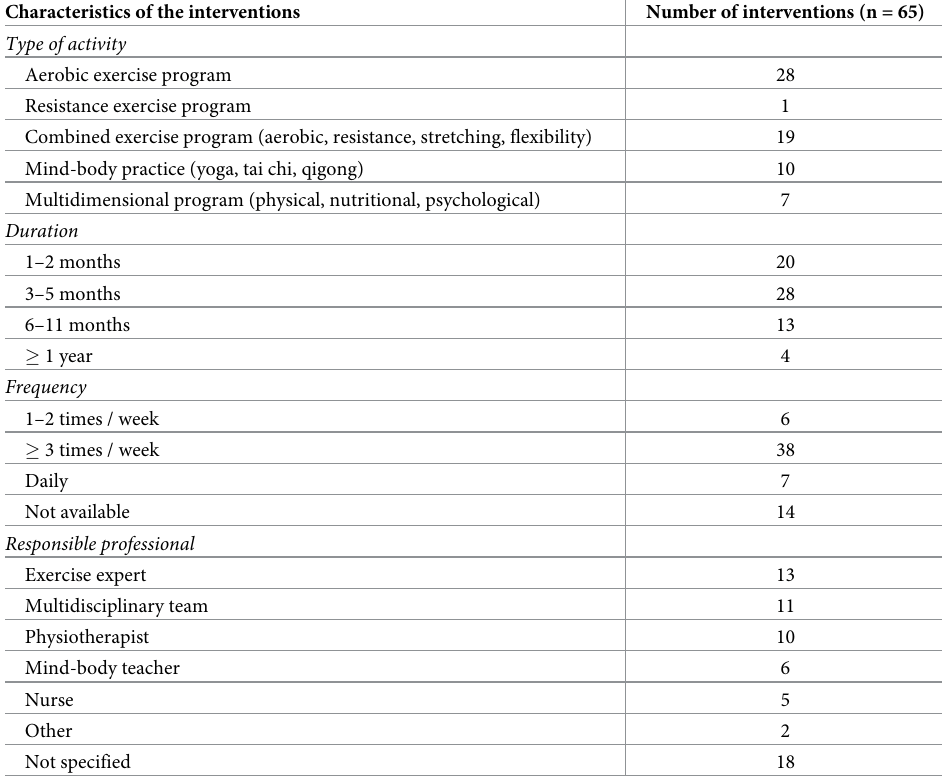
Table 3. Summary of self-managed interventions: Type of activity, duration, recommended frequency, and pro- fessional in charge of managing cancer survivors. Characteristics of the